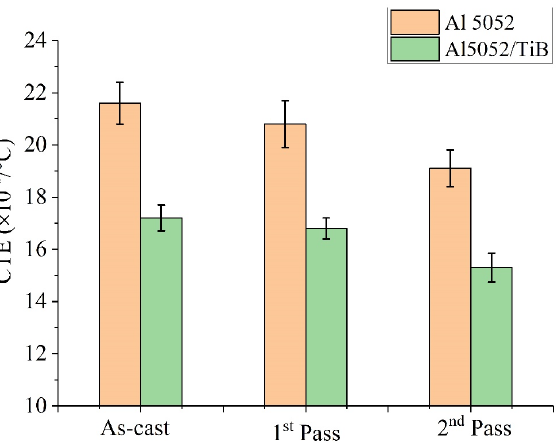
Figure 9. Thermal expansion behavior of the samples.